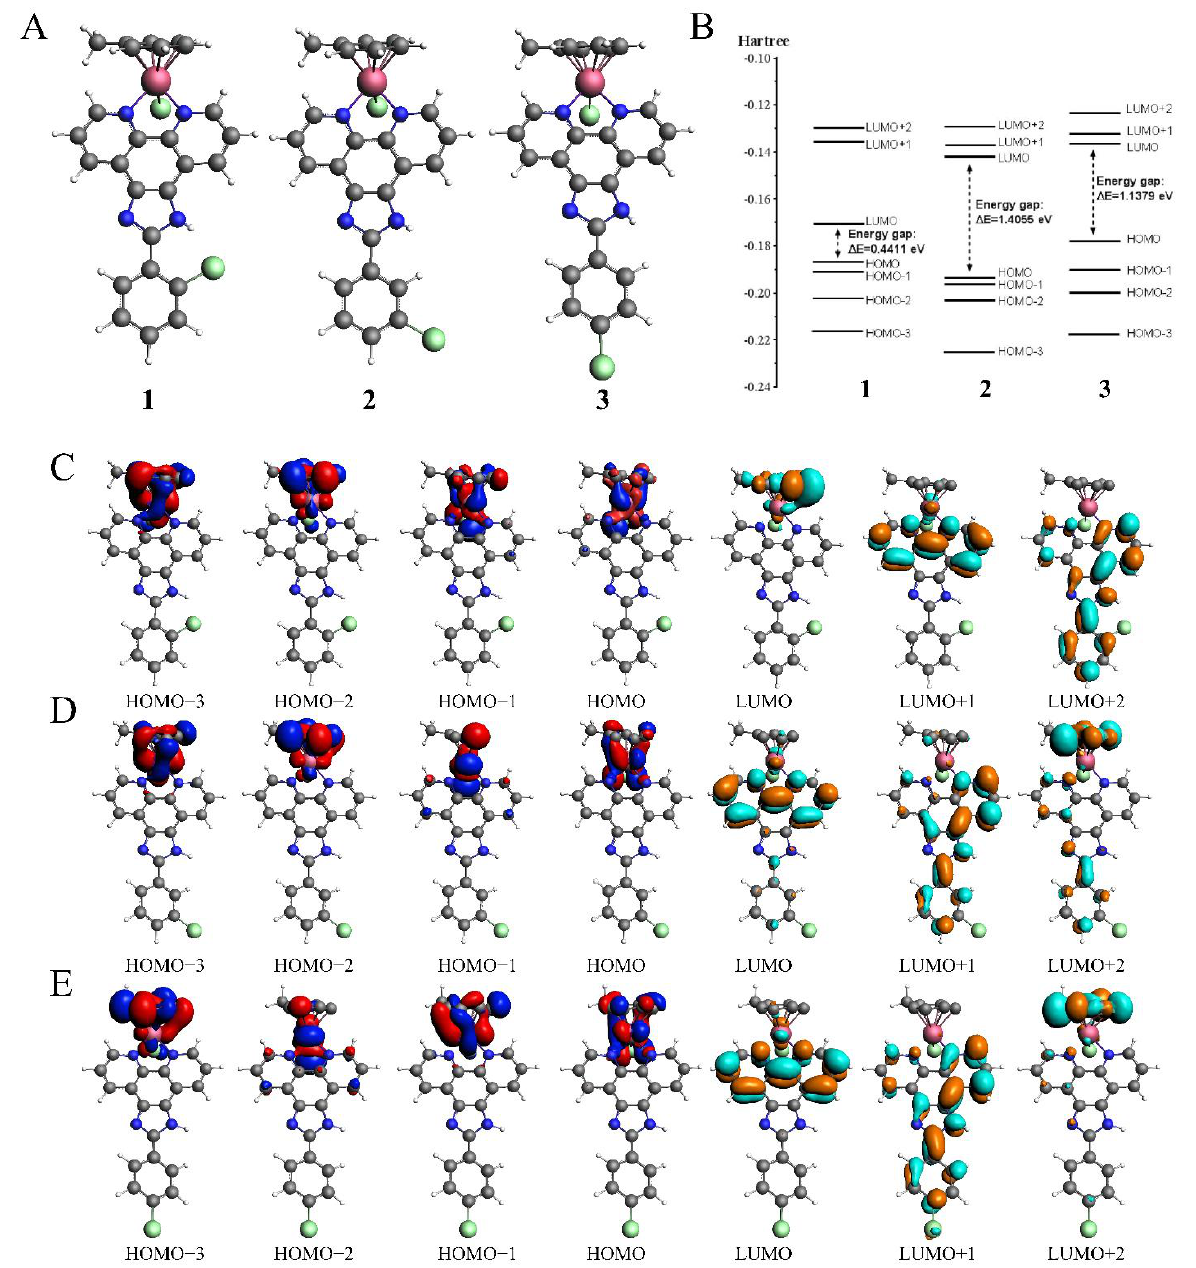
Figure 1. ( A ) Molecular structures of 1 , 2, and 3 . ( B ) Gas-phase highest occupied molecular orbital (HOMO) and lowest unoccupied molecular orbital (LUMO) energies of 1 , 2, and 3 (in hartree). ( C ) HOMOs (first four) and LUMOs (last three) of 1 ( C ), 2 ( D ), and 3 ( E ).